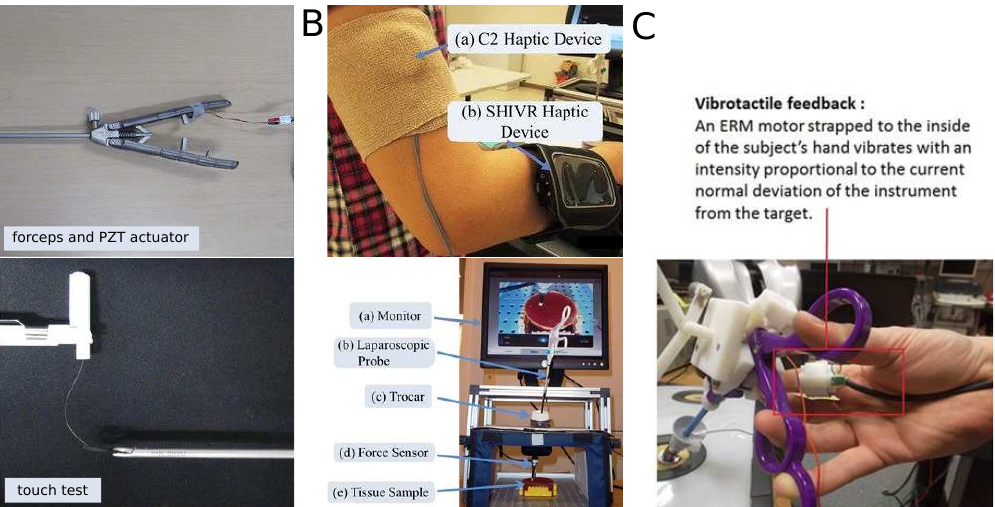
Figure 4. Vibrotactile devices. ( A ) stochastic resonance for laparoscopic surgical instruments [21]; ( B ) combination of vibrotactile (upper arm) and stochastic resonance (forearm) stimulations for lump detection [22]; ( C ) vibrotactile feedback for tool guidance